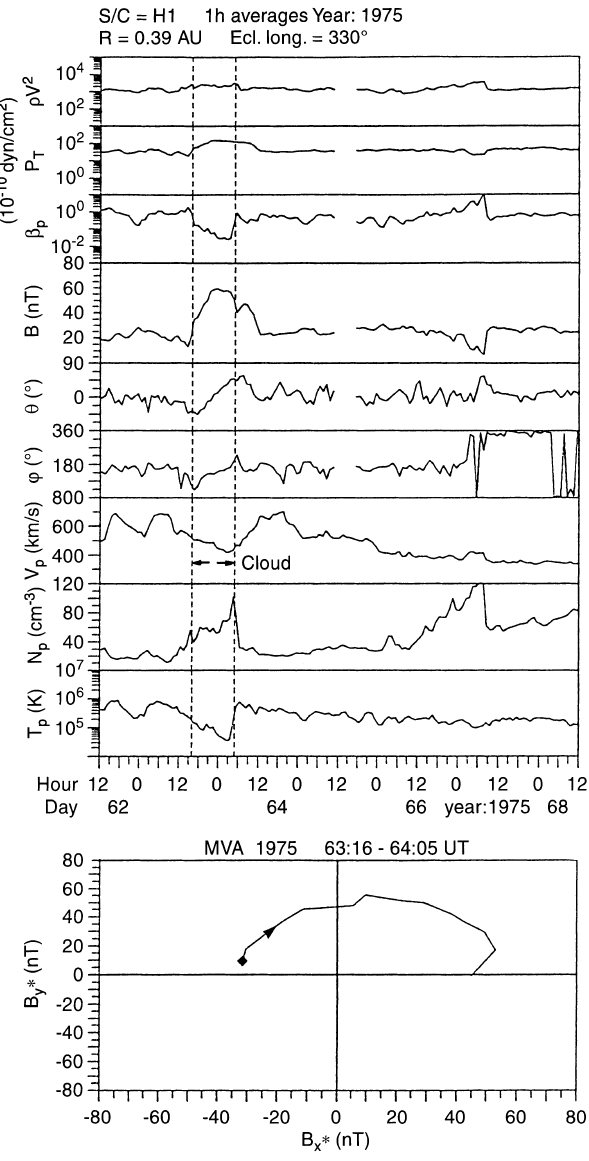
Fig. 1. Solar wind parameters for an MC ( dashed lines ) observed with Helios 1 at 0.4 AU in March 1975, day 63, 16 UT – day 64, 05 UT. Top to bottom : solar wind momentum flux (cid:113) V 2 , total plasma p pressure P T (cid:133) 10 (cid:255) 10 dyn/cm 2 (cid:134) , plasma- (cid:98) calculated from the proton p parameters, magnetic field magnitude B (cid:137) nT (cid:138) , polar and azimuthal angles (cid:104) , (cid:117) of the magnetic field vector in solar ecliptic coordinates, proton velocity V p , proton number density N p , and proton temper- ature T p . The bottom part of the figure shows the rotation of the magnetic field vector in the plane of maximum variance for the time interval of the MC. The diamond denotes the initial point of the plot and the arrow indicates the direction of the rotation of the